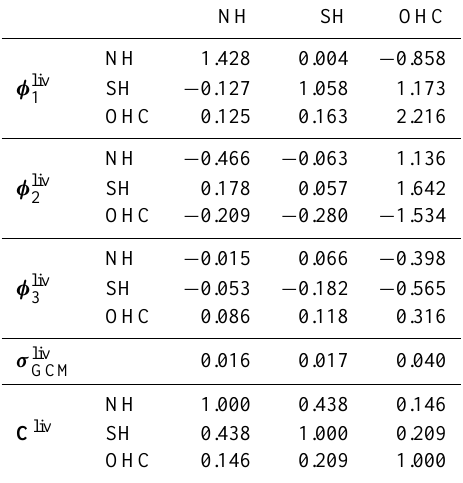
Table A2. Parameter estimates (posterior means) for the VAR(3) process in the main